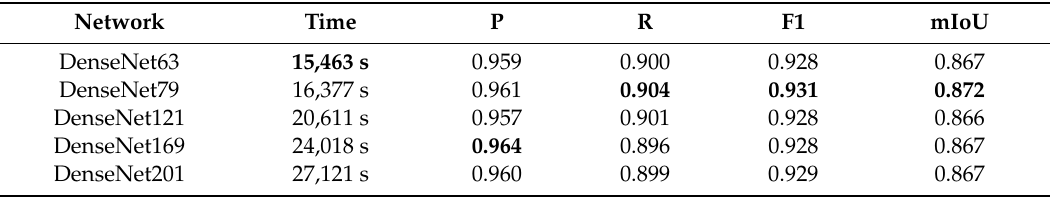
Table 1. Comparison of DenseNets with di ff erent layers. The optimal value for each metric is shown in bold. (P refers to Precision; R refers to Recall; F1 refers to F1 score and mIoU refers to mean Intersection over